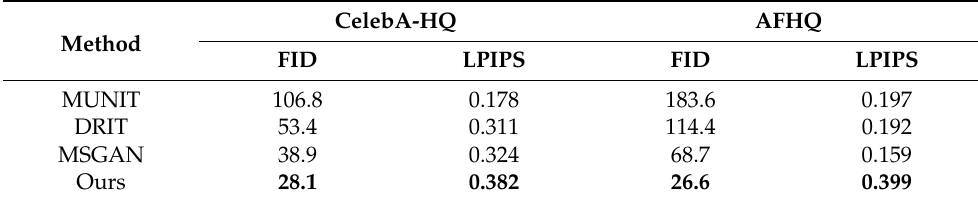
Table 2. Quantitative comparison of reference-guided synthesis. (The bold number indicates the best